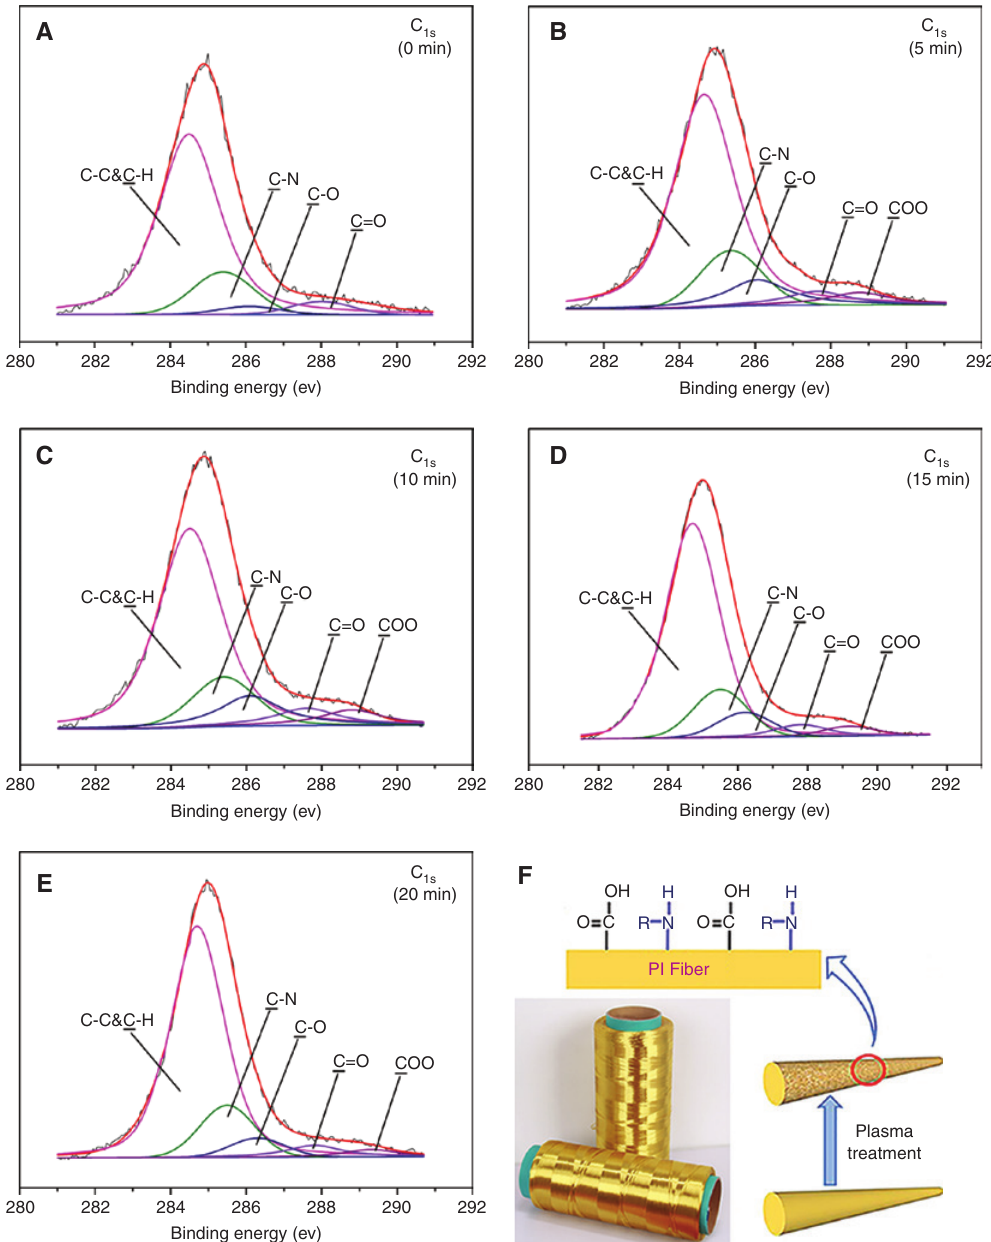
core-level spectra: (A) untreated; (B) 5 min; (C) 10 min; (D) 15 min; (E) 20 min; (F) schematic images of the PI fibers after Figure 1: The C 1S plasma